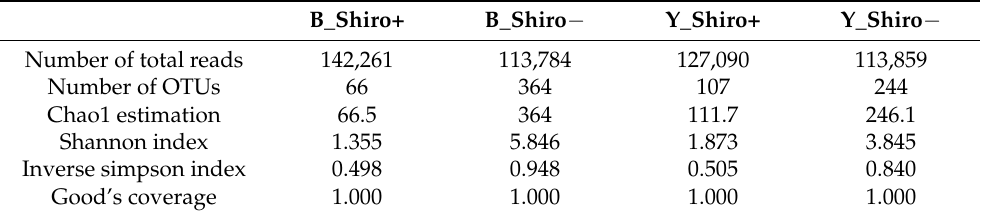
Table 3. Summary of Illumina sequencing and statistical analysis of fungal communities inhabiting the Tricholoma matsutake production (shiro+) and nonproduction (shiro − ) soils of Bonghwa (B) and Yangyang (Y) sampling sites.